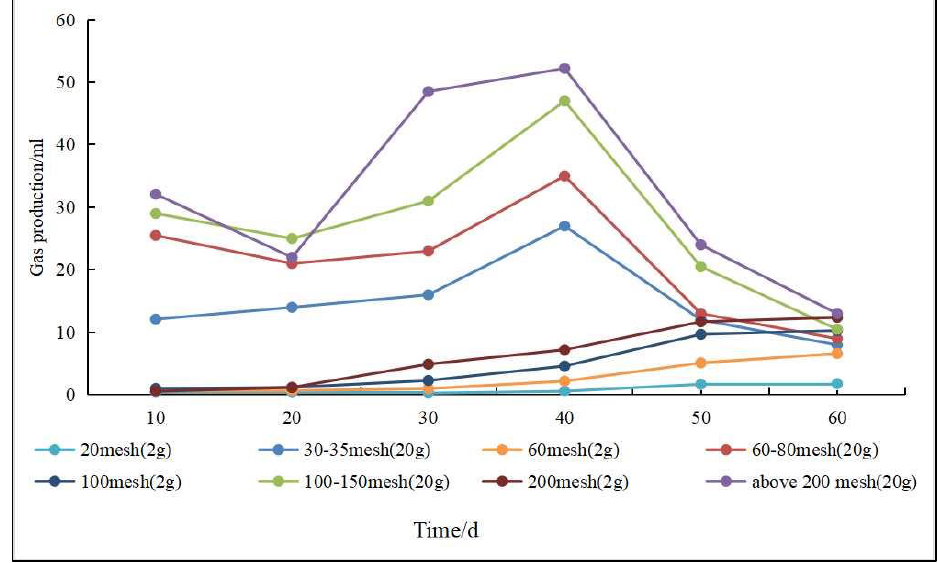
Figure 7. The relationship between particle size and gas production (Adapted from